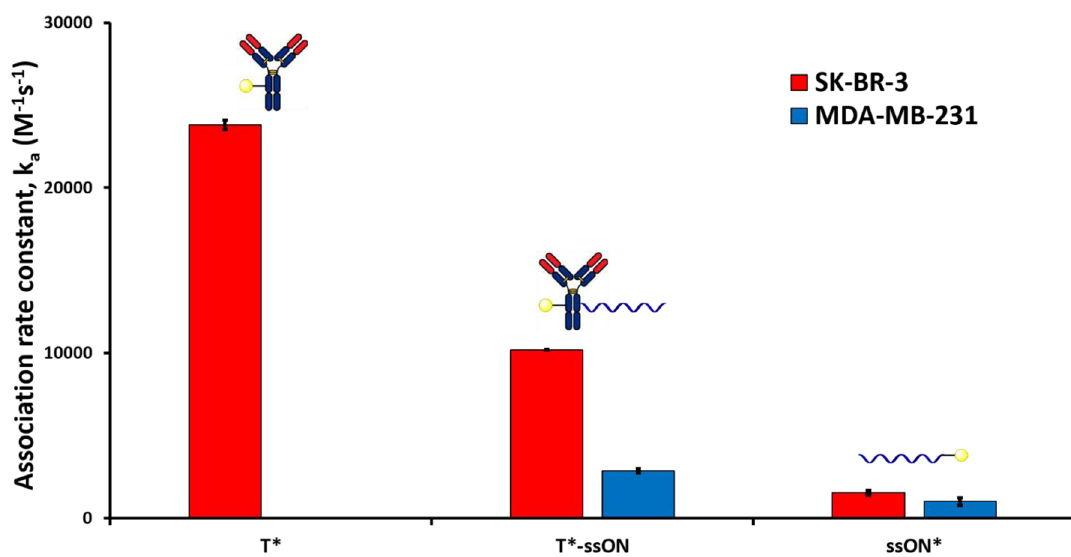
Figure 2. Association rate constants (k a ) of unconjugated trastuzumab (T*), trastuzumab- single-stranded ON conjugate (T*-ssON) and free single stranded ON (ssON*) on SK-BR-3 (HER2 + cell line, red bars) and MDA-MB-231 (HER2 − cell line, blue bars) measured using the time-resolved analysis of ligand binding assay (Fig. S3, S4, and S13). The symbol * indicates fluorescein labelling. Error bars indicate the standard error of the fitted parameter k a